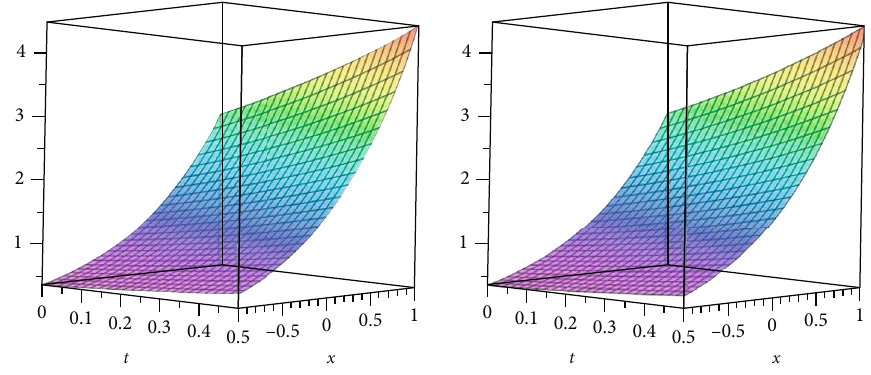
Figure 1: Graph of exact and analytical results of Problem 3.1.